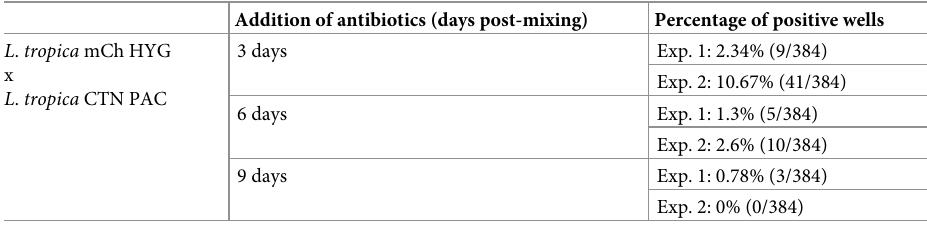
Table 3. Intraclonal hybrid formation in L .